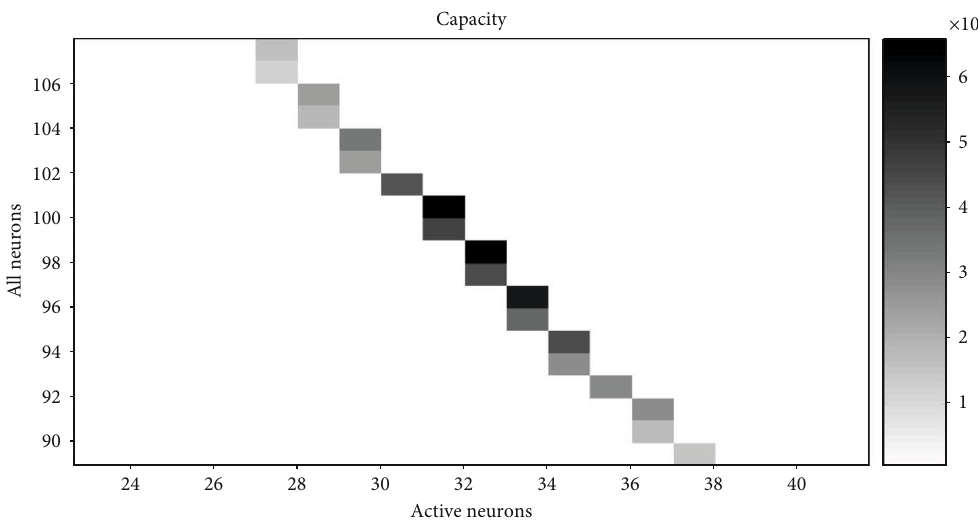
Figure 8: The representational capacity of di ff erent neural